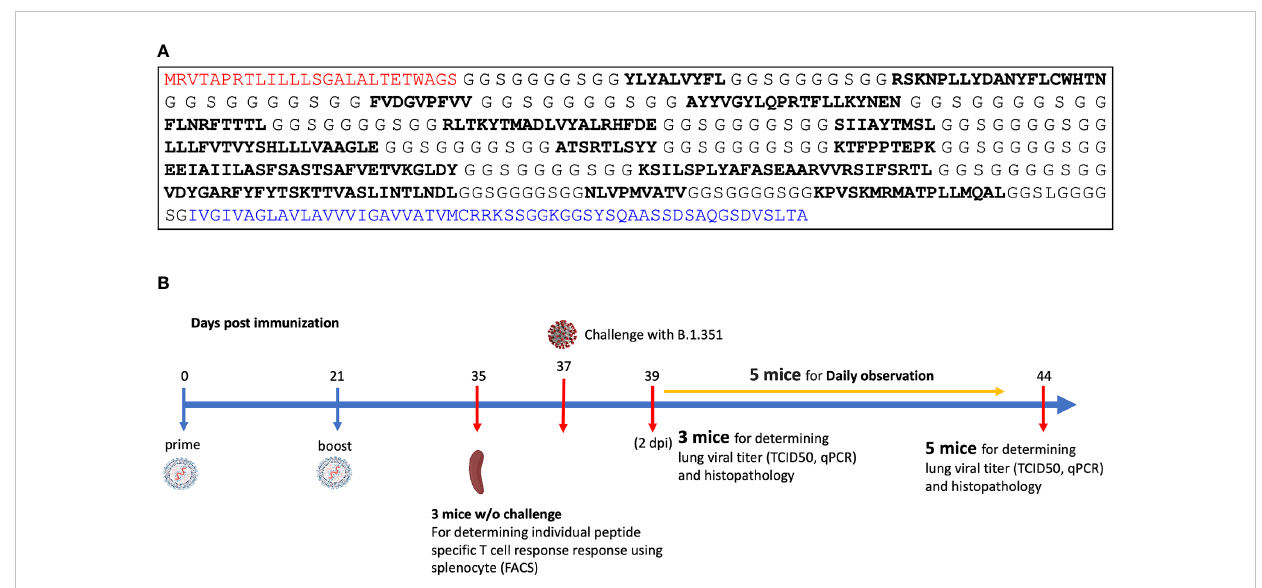
Figure 12). The lack of HLA-A*02:01 transgenic animal response to certain CD8 + epitopes that were immunogenic in